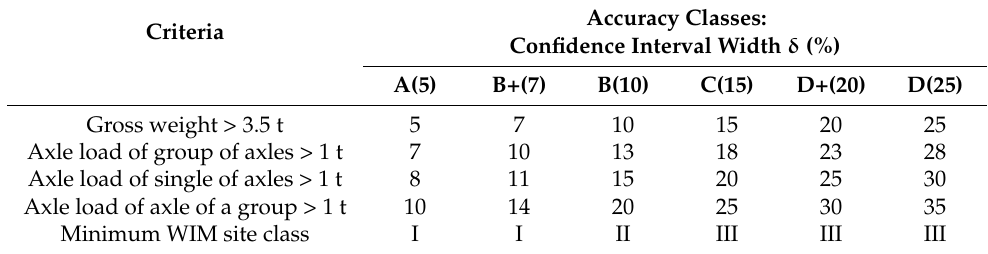
Table 2. WIM accuracy classes. Data from [21].